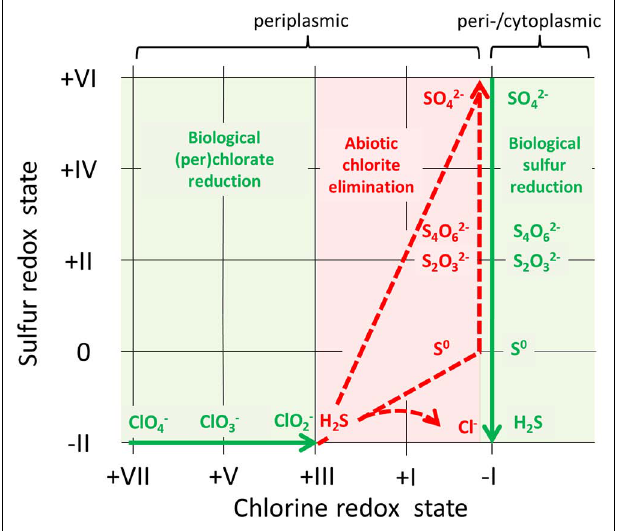
FIGURE 1 | Complete (per)chlorate reduction by Archaeoglobus fulgidus VC-16 involving a biotic–abiotic reaction loop depending on sulfur. Biological processes are illustrated with green arrows indicating the direction of a respective reaction, whereas dashed red arrows stand for abiotic reactions. Chlorine and sulfur compounds relevant for the complete reduction of perchlorate are